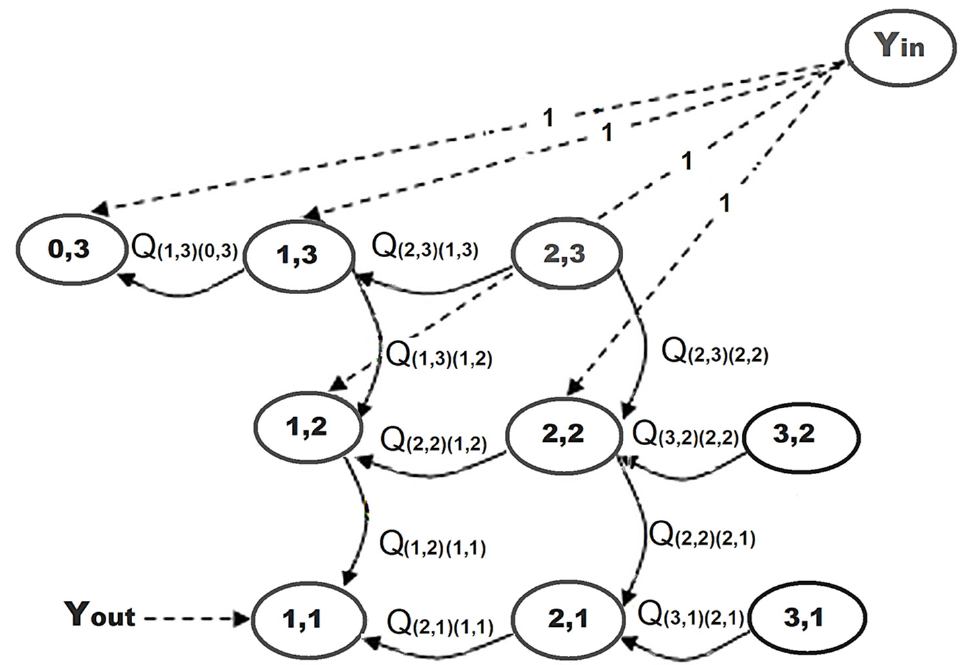
Figure 5. Second case of transition from states (1,3) or (2,3) or (1,2) or (2,2) or (2,1) into state (1,1).